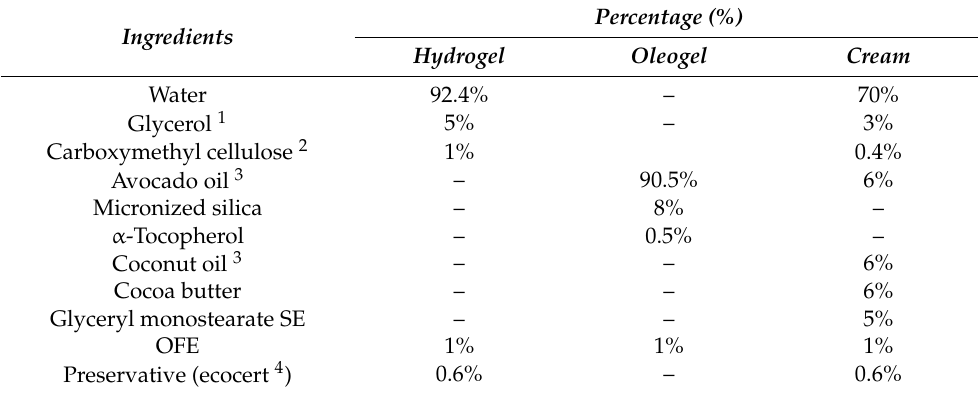
Table 1. Composition of the three